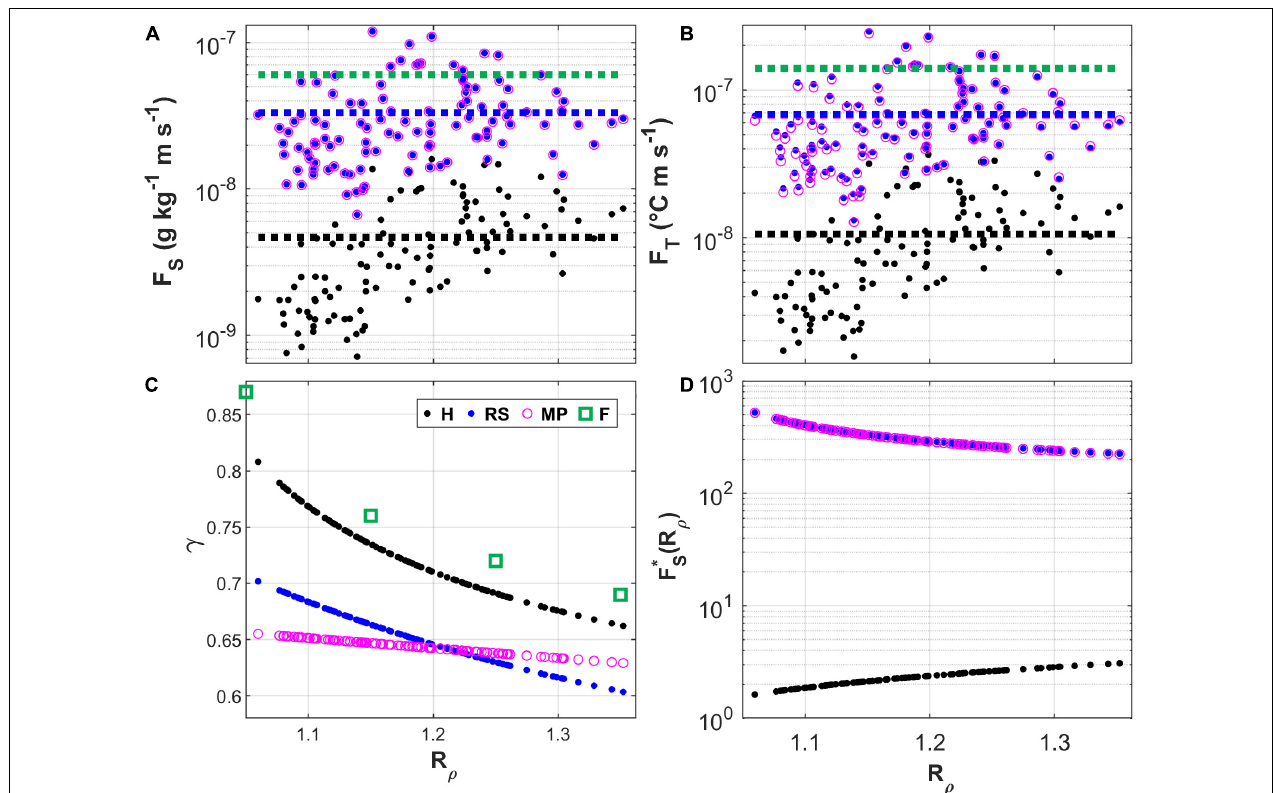
FIGURE 5 | (A–C) Comparison of the calculations of salt flux, heat flux, and flux ratio with different methods (H = H88; RS = RS12; MP = MP21; F = Ferron et al., 2021). (D) The relationship between salt fluxes and R ρ ; F S ∗ (R ρ ) denotes the part dependent on R ρ in equations (3)–(5). In (A) and (B) , the dashed lines represent mean values calculated for the period 2013–2014 in the 600–2800 m depth range, and the axes expressing the fluxes are set to the logarithmic